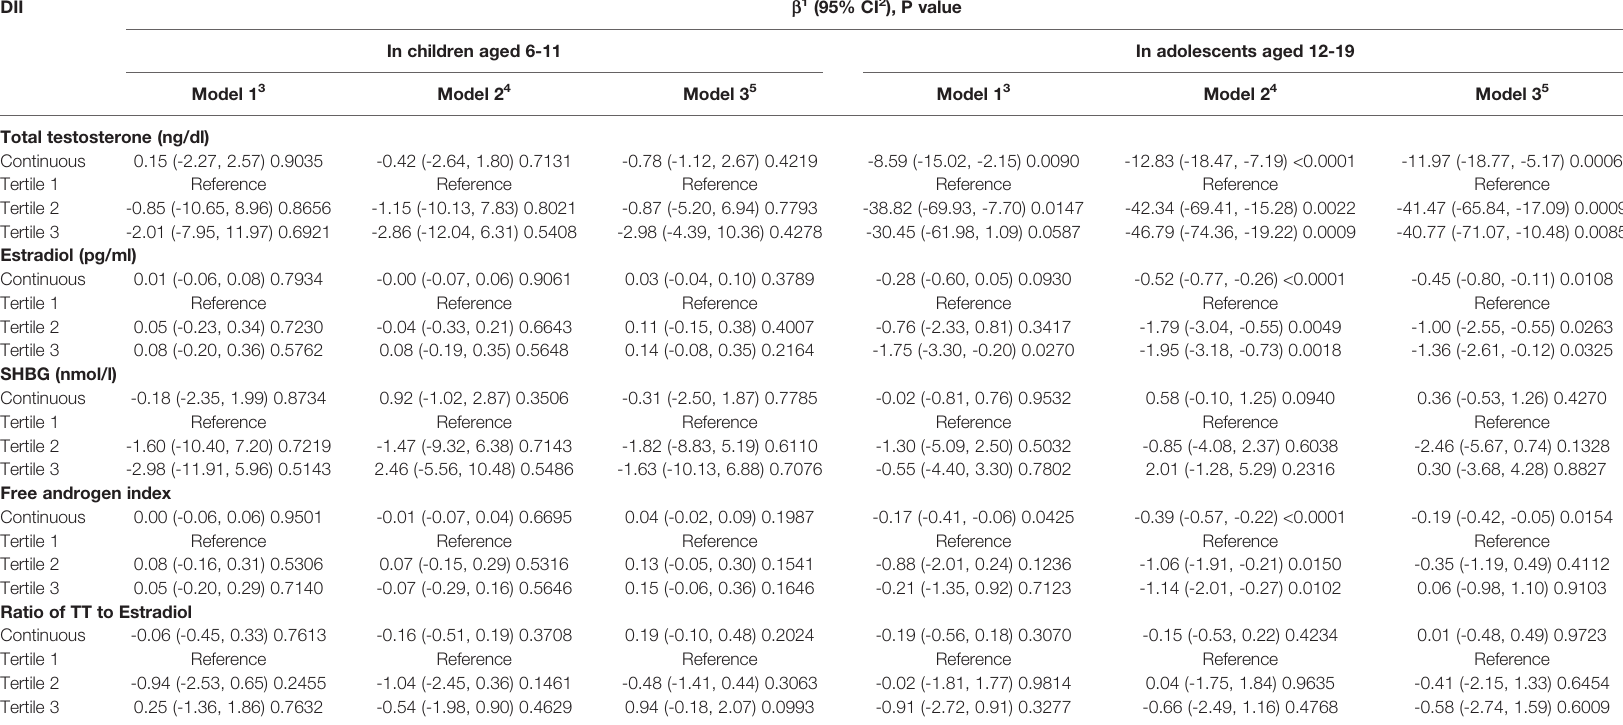
TABLE 2 | Association between dietary in fl ammatory index with sex hormone in children aged 6-11 and adolescents aged 12-19, weighted.